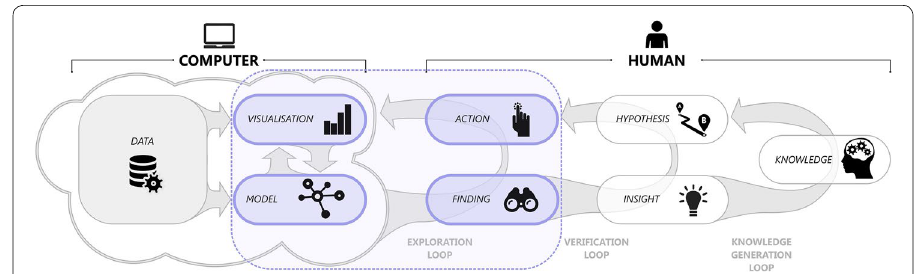
Fig. 2 Knowledge generation model [33], redrawn (blue shading indicates research